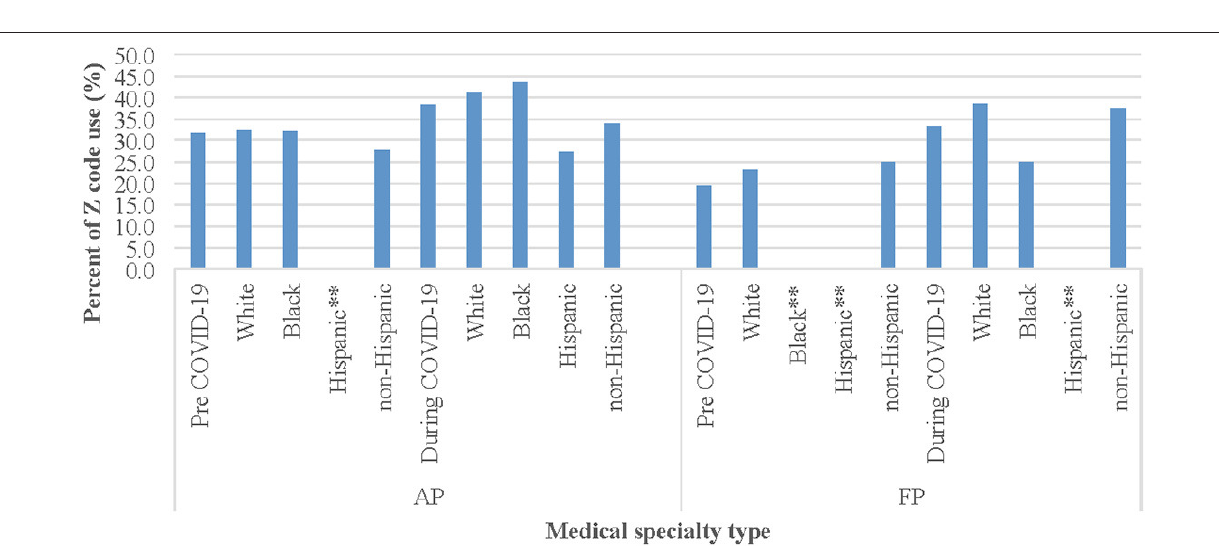
FIGURE 4 | Z code use among racial and ethnic groups by medical specialty type before and during COVID-19 * . * Note: Before COVID-19 period: 1/2/2019-3/5/2020; During COVID-19 period: 3/6/2020-1/14/2021. AP = Addiction Psychiatry; FP = Forensic Pathology. ** Percentages of Z code use among these racial and ethnic groups in AP visit and FP visit were not available because there were no such visits/observations (as